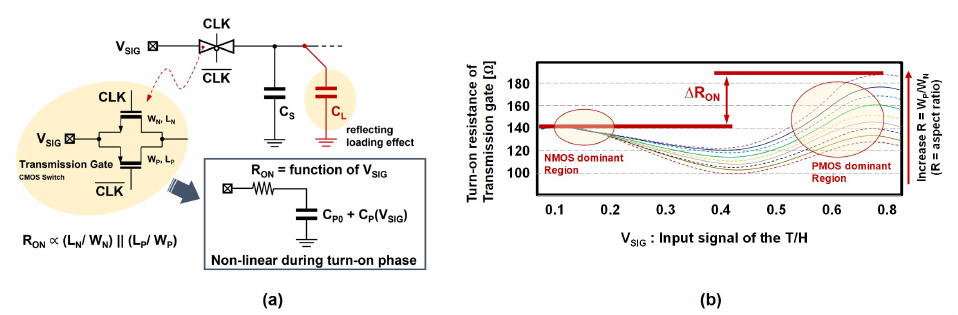
Figure 3. ( a ) Schematic of sampling network (T/H) and ( b ) turn-on resistance of transmission gate with different transistor aspect ratios; data from